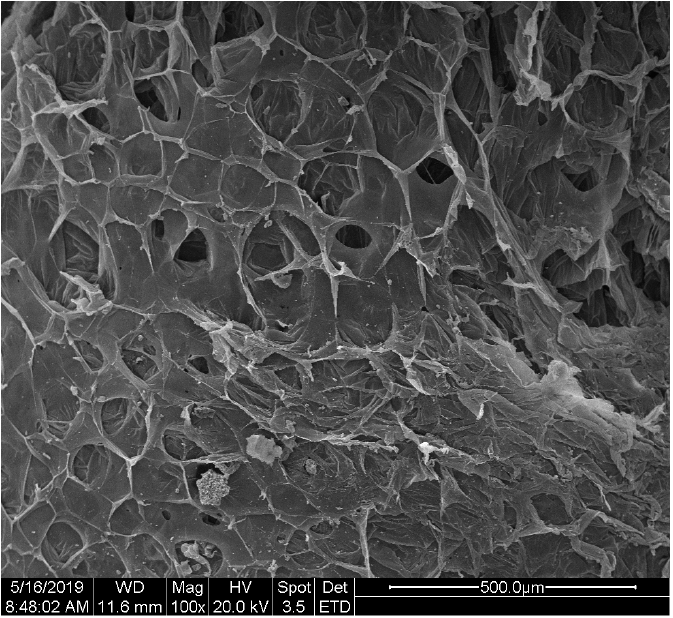
Figure 1. Scanning electron micrography of expanded polystyrene (EPS) enlarged 100 times.